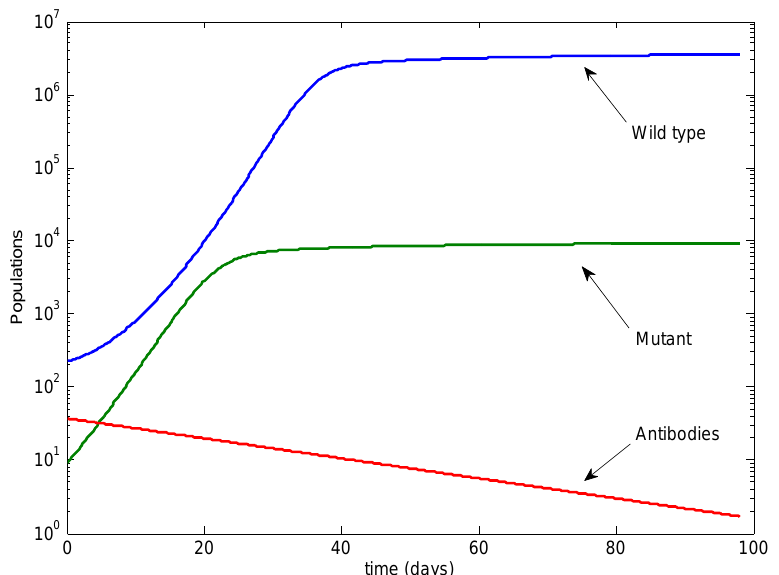
Figure 2. The baseline case with no antibody infusions after infection. Note the log scale on the vertical axis.